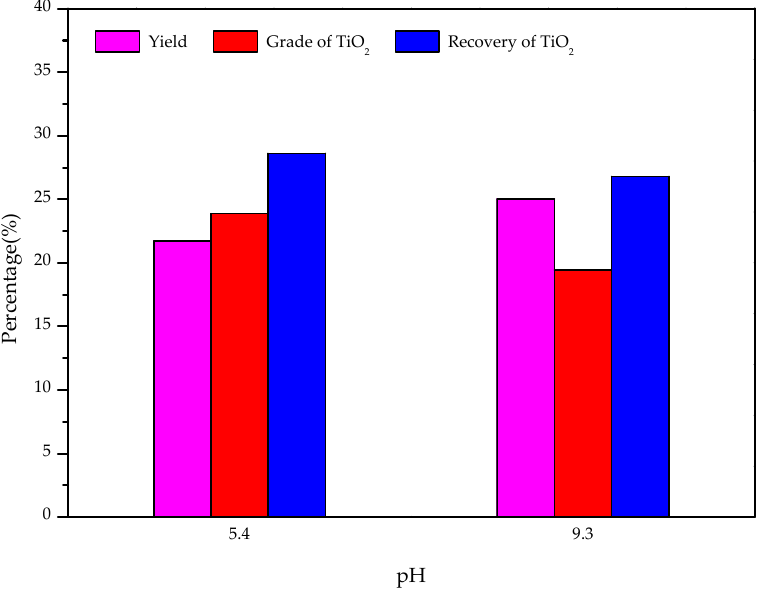
Figure 13. The yields, TiO 2 grades, and recoveries of the concentrates from modified slag flotation at different pH levels.